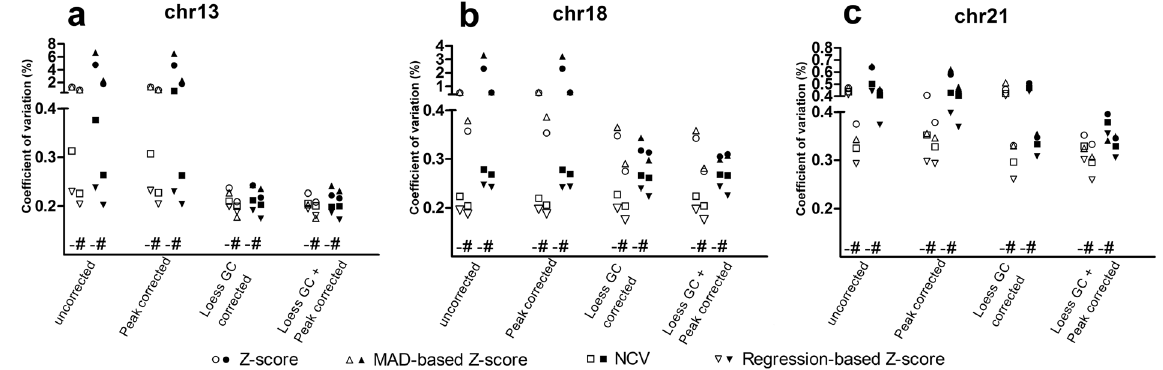
Figure 4. Effect of chi-squared-based variation reduction on the CV of control samples. SOLiD (white) and Illumina data (black) with no other correction, or with a peak correction, or LOESS GC correction or both LOESS GC and peak correction. For each type of correction the CVs of four prediction algorithms (standard Z-score, MAD-based Z-score, Normalized Chromosome Value and regression-based Z-score) are shown for ( a ) chromosome 13, ( b ) chromosome 18 and ( c ) chromosome 21. – not chi-squared corrected; # chi-squared